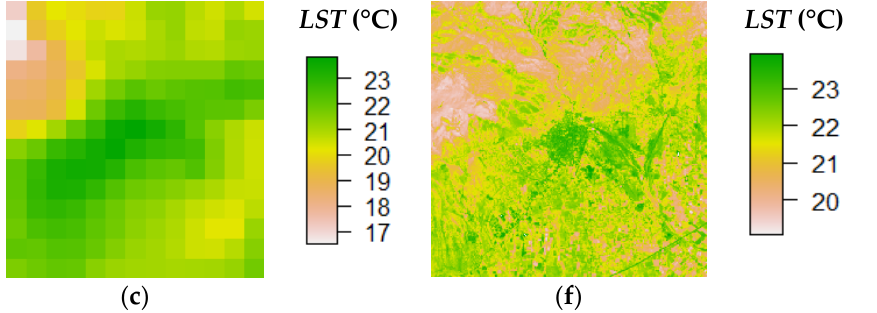
Figure 7. ( a ) The MODIS LST image (1000 m) on 5 August 2016 (12:34 UTC + 3). ( b ) The MODIS LST image (1000 m) on 5 August 2016 (14:27 UTC + 3). ( c ) The MODIS LST image (1000 m) on 5 August 2016 (1:34 UTC + 3). ( d ) The downscaled image (10 m) on 5 August 2016 (12:34 UTC + 3). ( e ) The downscaled image (10 m) on 5 August 2016 (14:27 UTC + 3). ( f ) The downscaled image (10 m) on 5 August 2016 (1:34 UTC + 3). Table 9. The LST values for both city and suburbs at 1000 m and 30 m spatial resolution. Table 8. The LST values in both city and suburbs at 1000 m and 10 m spatial resolution.